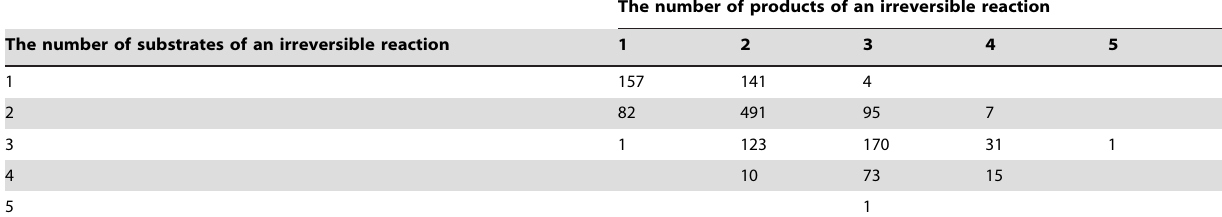
Table 1. The distribution of irreversible reactions classified by their numbers of substrates and products.